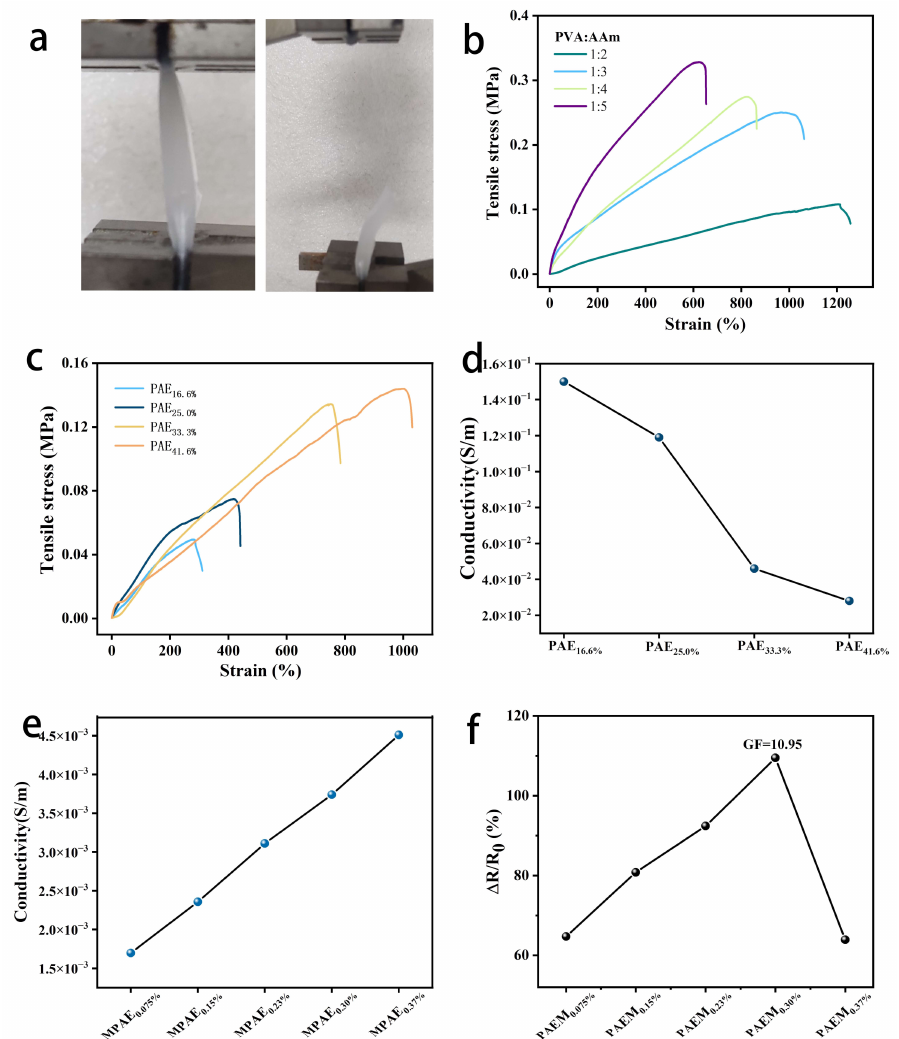
Figure 5. ( a ) Tensile and fracture of hydrogels; ( b ) Tensile stress-strain curves of PA hydrogels (PVA:AAM = 1:2, 1:3, 1:4, and 1:5); ( c ) Tensile stress-strain curves of different volume fractions of PAEM (16.6, 25.0, 33.3, and 41.6%); ( d ) Different volume fractions of PAEM (16.6, 25.0, 33.3, and 41.6%); ( e ) variation of conductivity for different mass fractions of PAEM (0.075, 0.15, 0.23, 0.30, and 0.37%); ( f ) sensing properties of different mass fractions of PAEM (0.075, 0.15, 0.23, 0.30, and